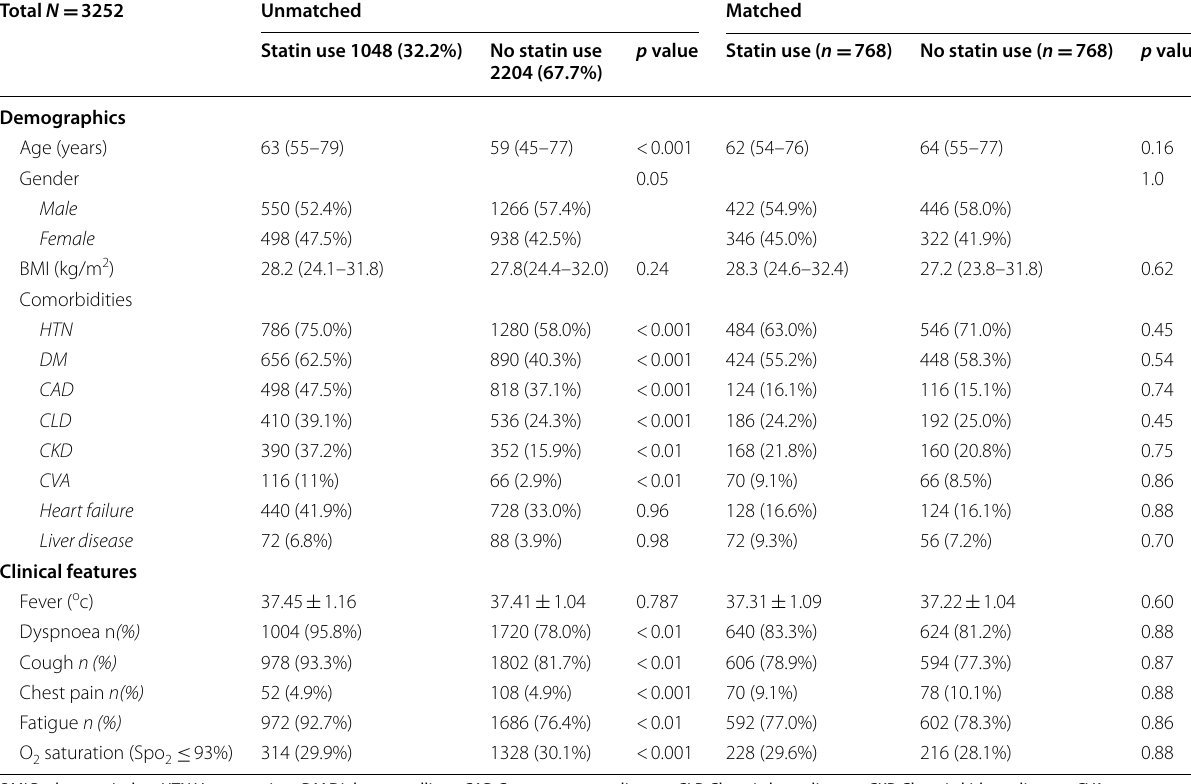
Table 1 Hospitalized patients demographics, persisting comorbidities, clinical manifestations, and variations among unmatched